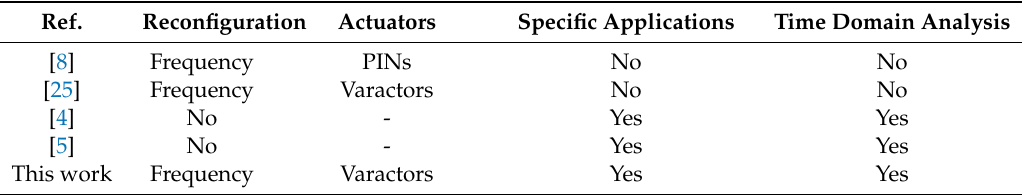
Table 6. Performance comparison with other designs in the